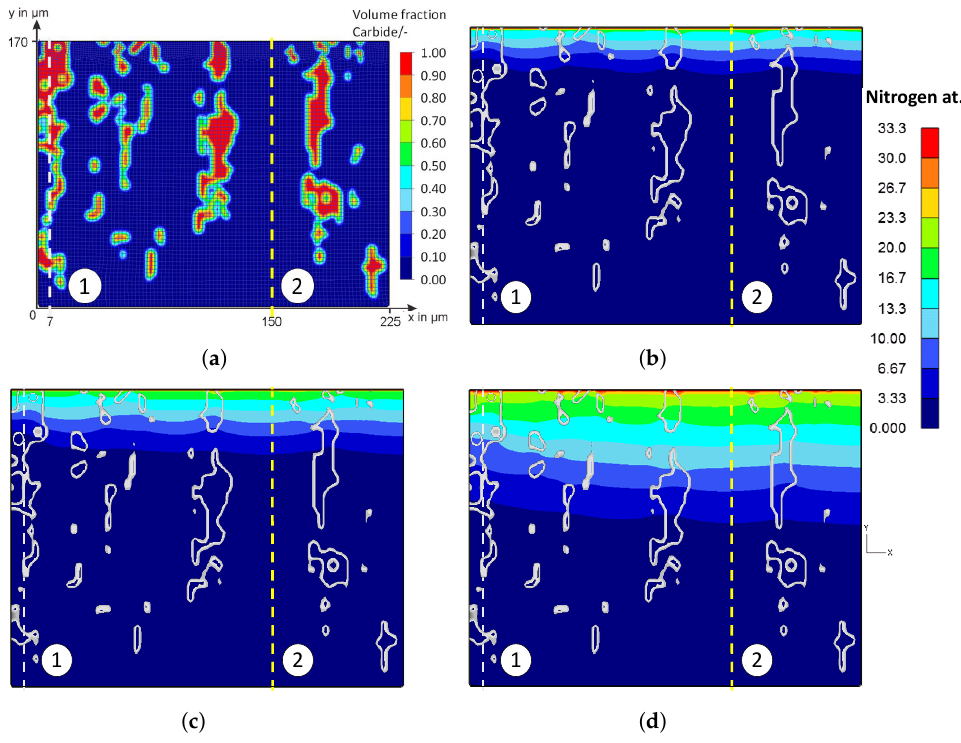
Figure 20. Simulation results of nitrogen diffusion in X153CrMoV12 tool steel during plasma nitriding. By taking the microstructure into account, here using the example of carbides, the heterogeneous ni- trogen concentration profile is recognizable. ( a ) Carbide-rich areas at place 1 (cid:13) (7µm) and carbide-poor areas at place 2 (cid:13) (150µm). ( b ) Nitriding profile after 2h. ( c ) Nitriding profile after 4h. ( d ) Nitriding profile after